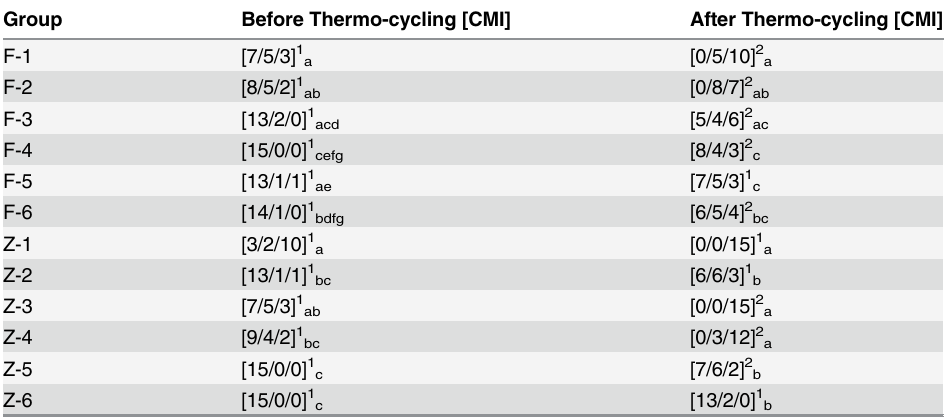
feature might be attributed to cross-linking at the interface because some alumina particles on the surface of the zirconia post generated during sandblasting reacted with the silane agent ( γ - MPTS) to form chemical bonds. An organic layer anchored on the post led to the increase in bonding strength. This effect was also enhanced by using the two-bottle experimental primer, which formed a flexible bi-layer due to BTS with a decreased cross-linking density.